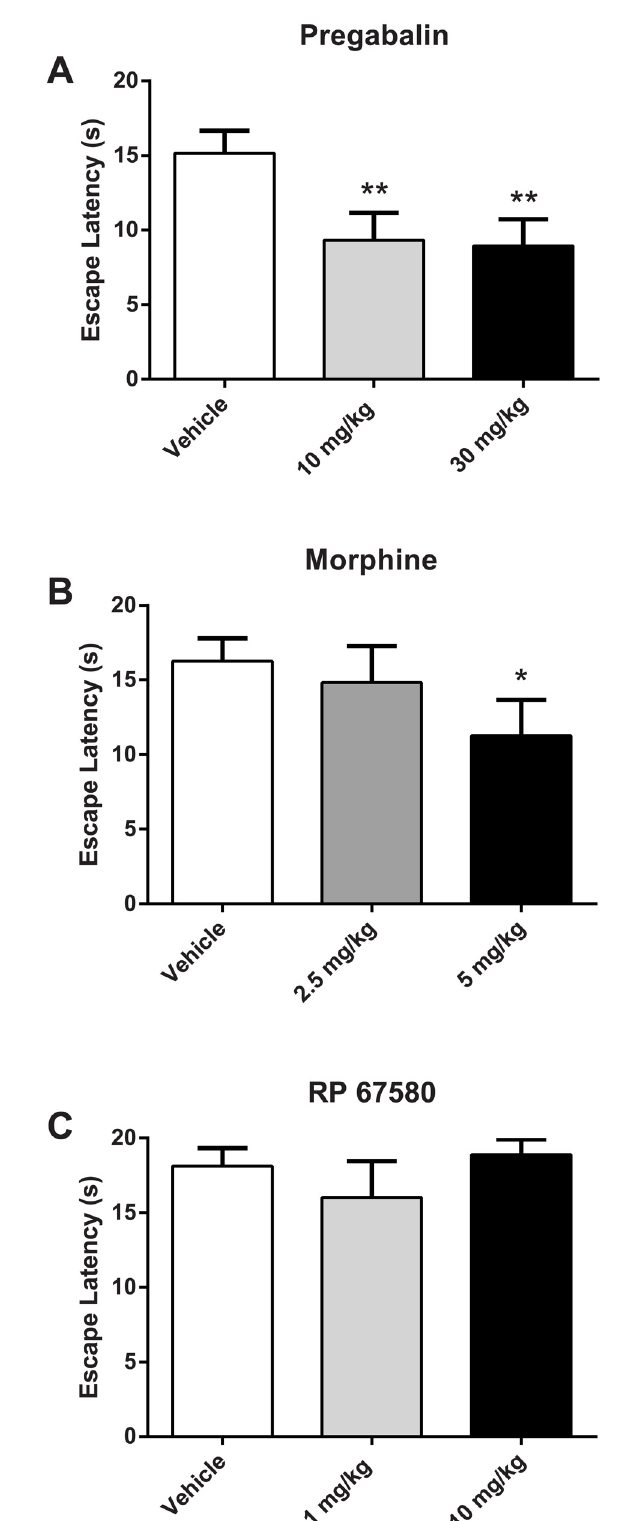
Fig 4. Effect of vehicle and drug administration on the escape latency of CCI rats impeded by 3 mm probes. Compared to vehicle administration, pregabalin ( Panel A , n = 14) and morphine ( Panel B , n = 9)